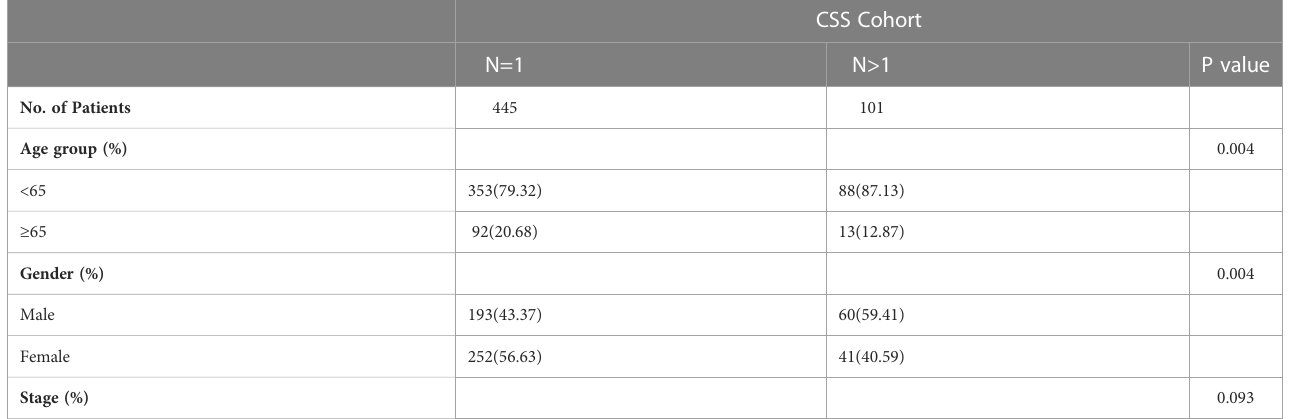
TABLE 5 Analysis of tumor number and associated variables in the CSS